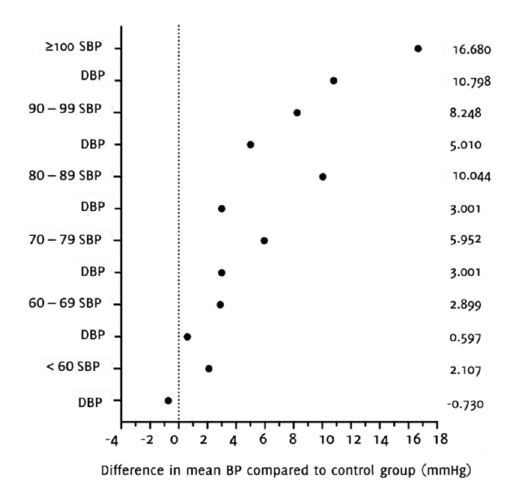
Figure 6 . Change of Systolic and Diastolic Blood Pressure Compared to Non- hypertensives, for Heart Rate